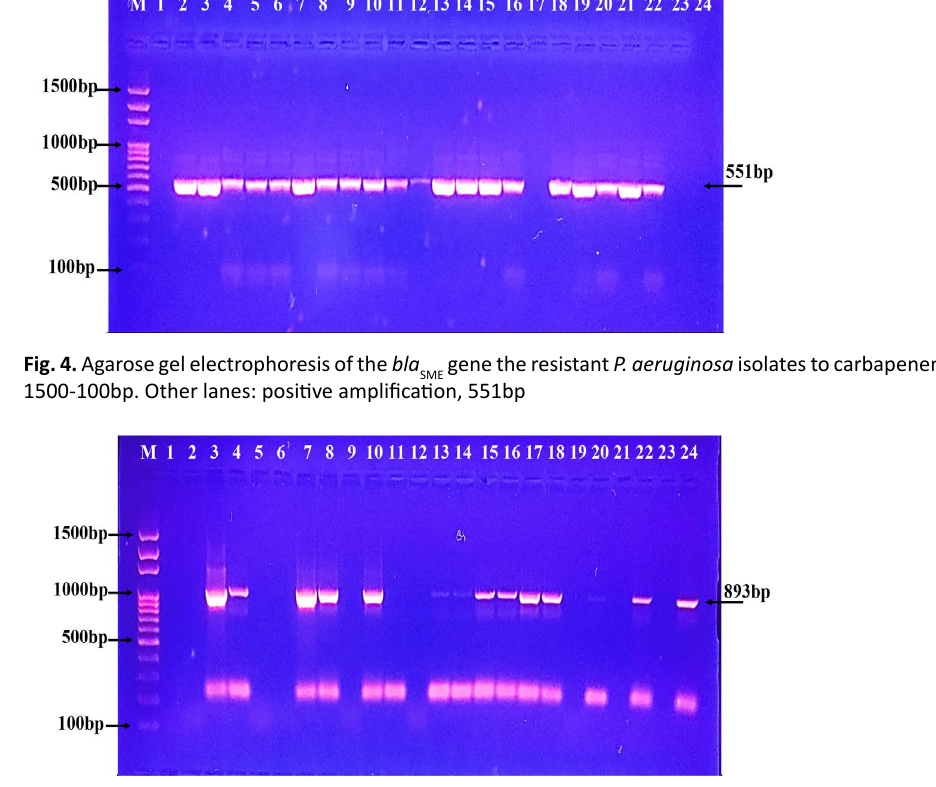
gene the resistant P. aeruginosa isolates to carbapenem. M: ladder, Fig. 5. Agarose gel electrophoresis of the bla KPC 1500-100bp. Other lanes: positive amplification, 893bp Table 3. The NCBI-BLAST Homology Sequence identity for the current study isolates of the P. aeruginosa resistant to